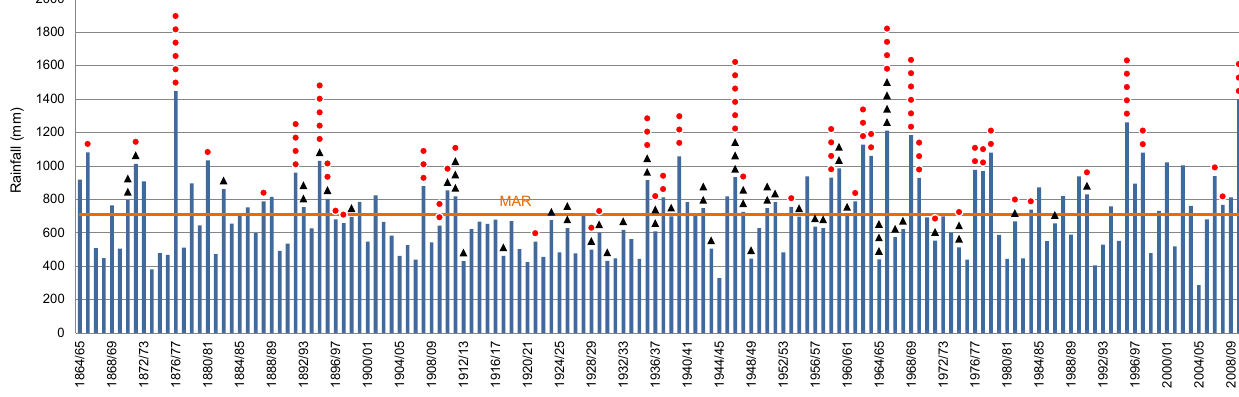
Figure 2. Annual rainfall (climatological year: September to August) at Lisboa-Geofísico rain gauge for the period 1864/1865–2009/2010. Orange line symbolizes the mean annual rainfall (MAR); red dots and back triangles symbolize rainfall-triggered landslide events and non- rainfall-triggered landslide events, respectively, at a distance up to 10km from the reference rain gauge.